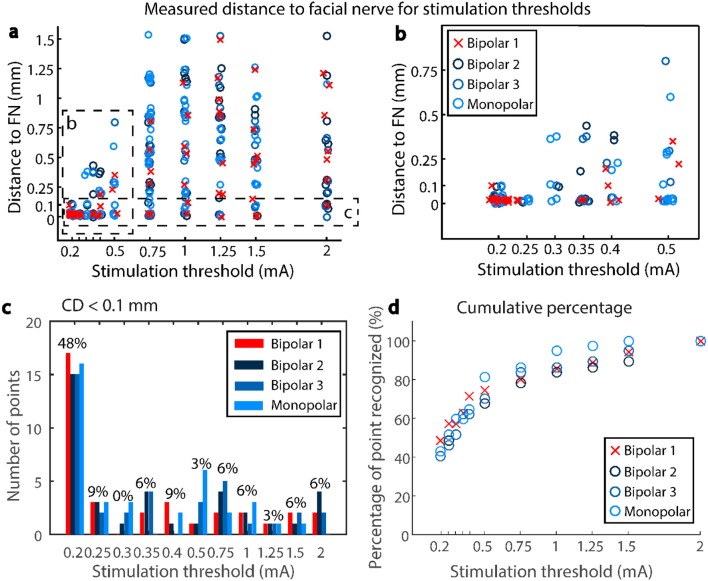
(a) Scatter plot of the stimulation thresholds and the corresponding measured distances to the facial nerve, for subjects 1,2, and 3. (b) Zoom into the lower stimulation thresholds, (c) number of points closer to the facial nerve than 0.1 mm which generate a CMAP at a given stimulus threshold, percentage only shown for Bipolar 1 (d) Cumulative percentage—percentage of points closer to the facial nerve than 0.1 mm recognized by a given stimulus threshold.